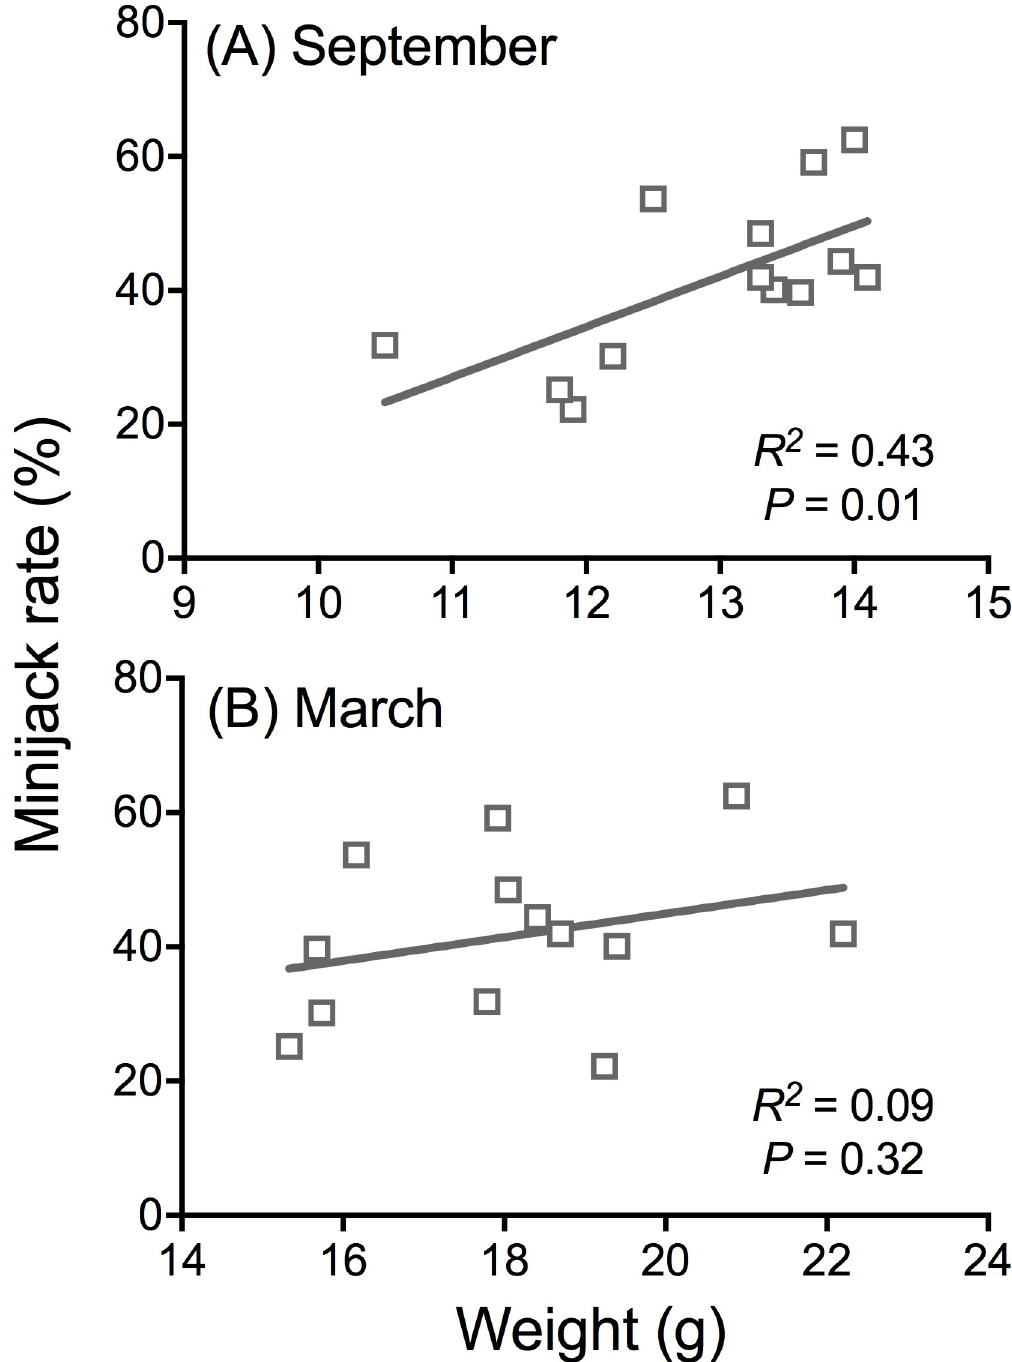
Fig 3. Seasonal relationships between mean fish weight and age-2 minijack rate (percent among males). (A) September vs. (B) March. FNDR and INT broodlines from BYs 1998–2011 were used for the linear regression analyses. The outliers (BYs 1998 & 2004) were omitted due to large difference in fall size/growth rate of these rearing years from all other